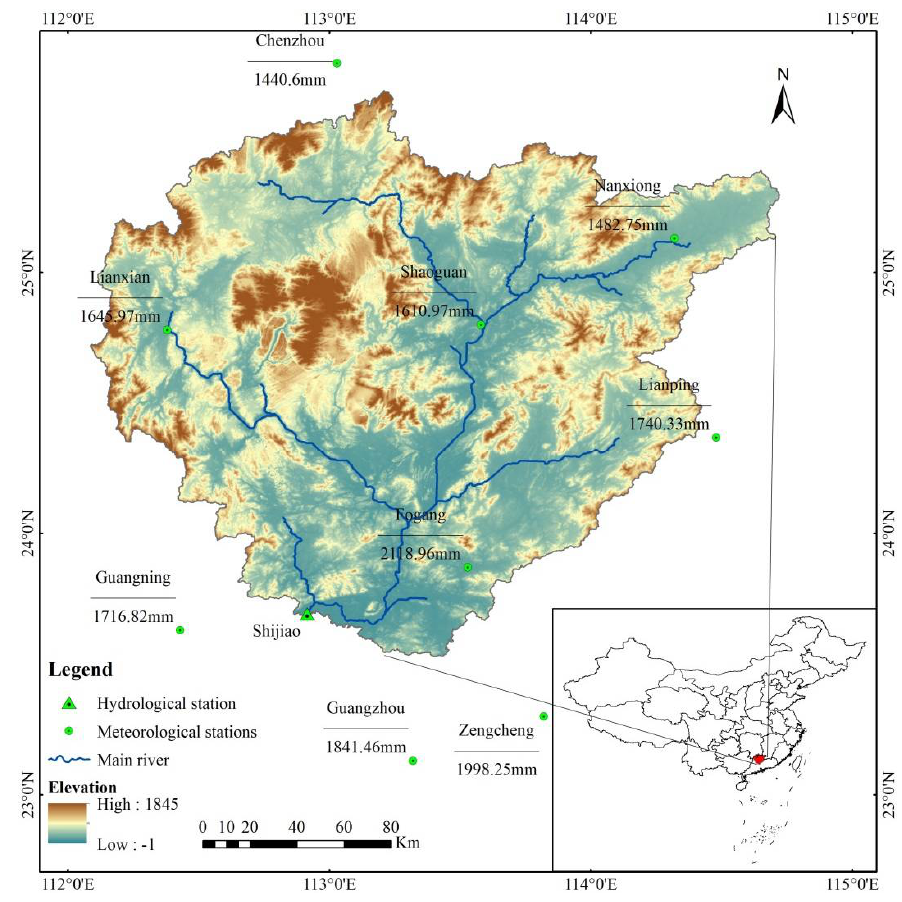
Figure 1. The topographic map of BJR and average annual precipitation of meteorological stations. Table 1. Annual precipitation of the meteorological